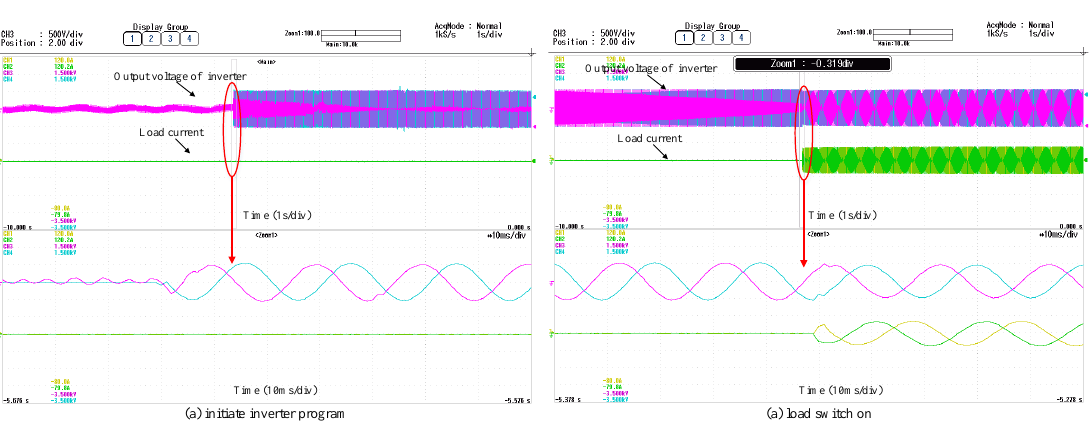
Figure 27. Off-grid mode waveforms: ( a ) initiate inverter program; ( b ) load switching on.